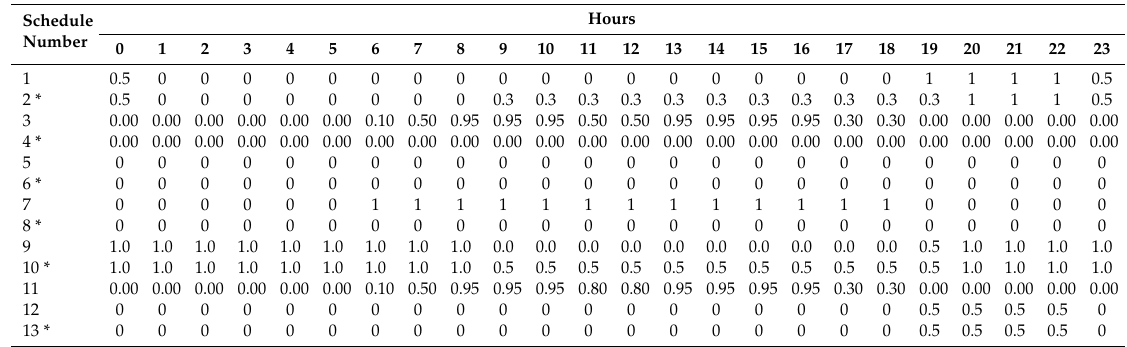
Table 3. The equipment schedule.